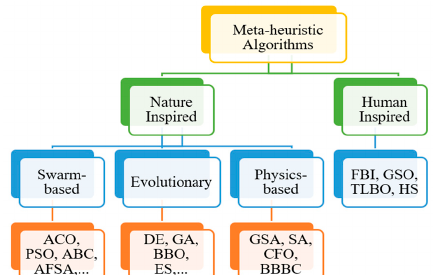
Figure 1. Different categories of meta-heuristic algorithms [10].